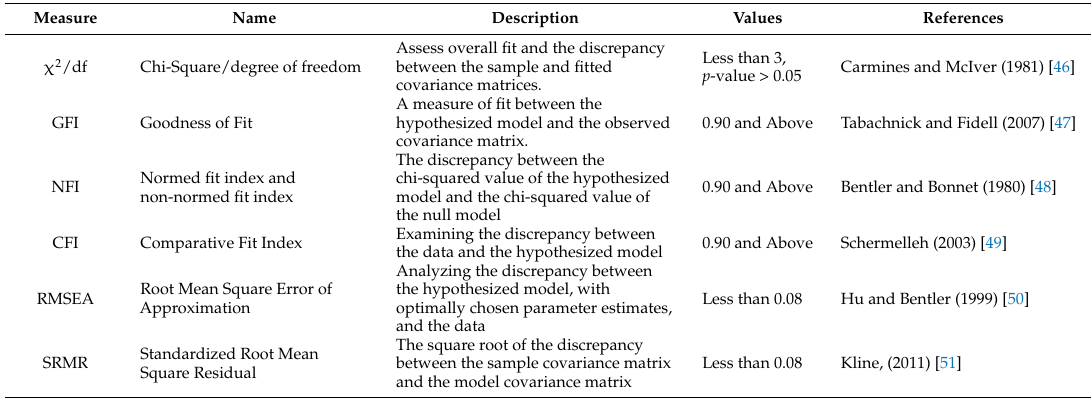
Table 2. The commonly used absolute fit indices.